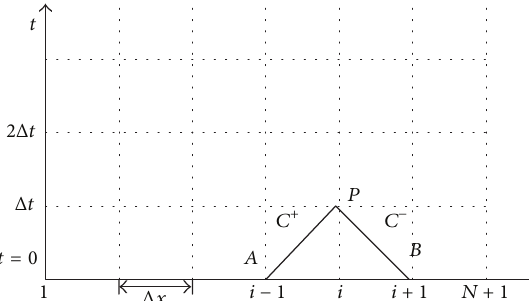
Figure 1: Characteristic line grid for water hammer